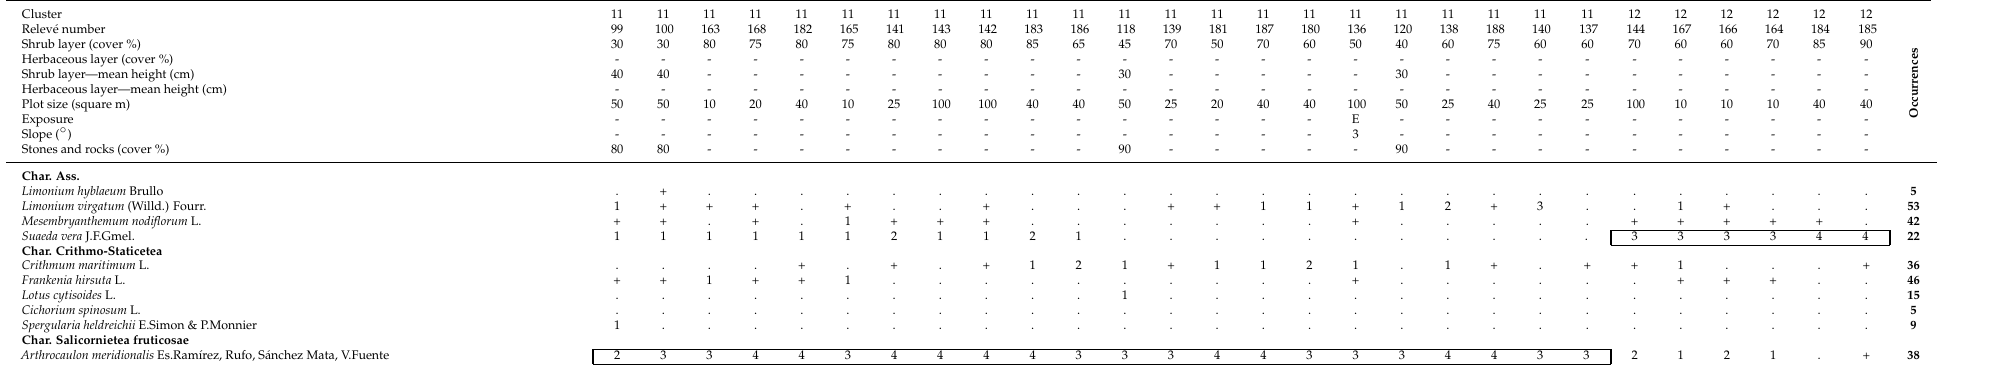
Table A6. Phytosociological relev é s from the Island of Capo Passero (SE Sicily)—rocky coast vegetation. Cluster 11 Relev é number